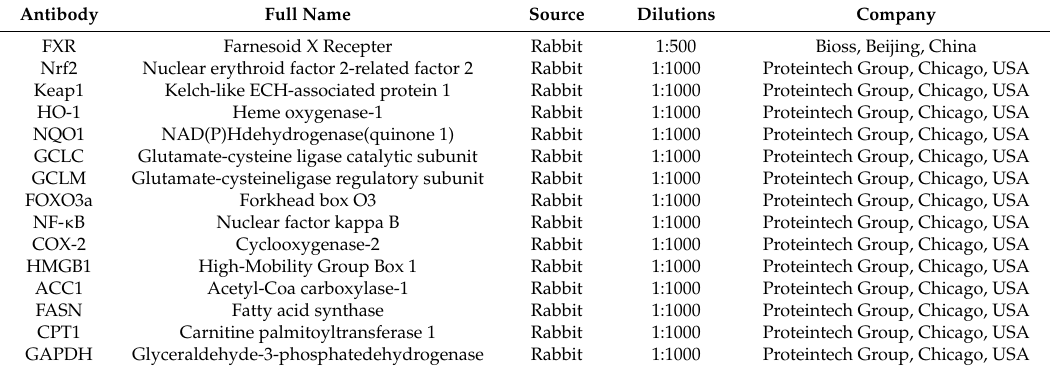
Table 2. Antibodies used for western